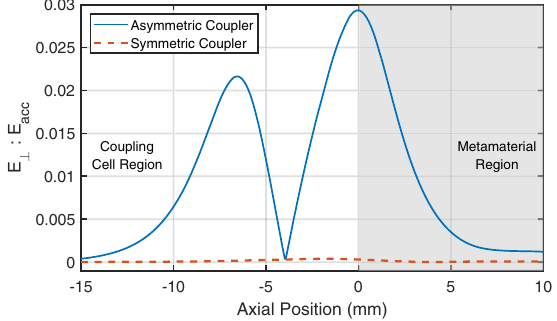
FIG. 6. The asymmetric mode in the Stage I/II coupling cell generated transverse electric field components in the fundamental mode. The magnitude of the deflecting field normalized to the accelerating gradient is shown in solid blue for the asymmetric design. The symmetry of the Stage III coupler eliminates this transverse field, as shown in dashed